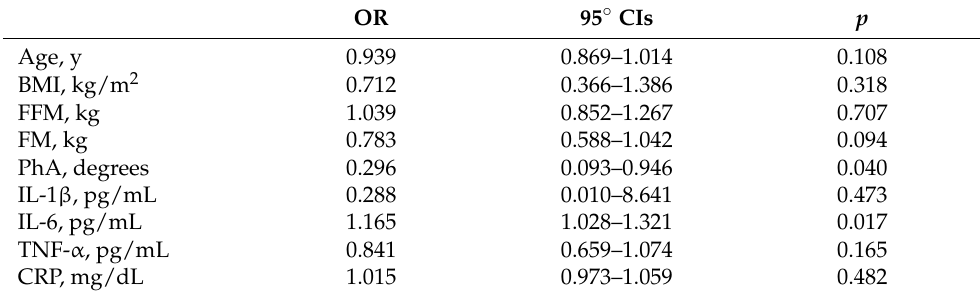
Table 4. Logistic regression analysis of predictors of malnutrition risk based on CONUT score. OR 95 ◦